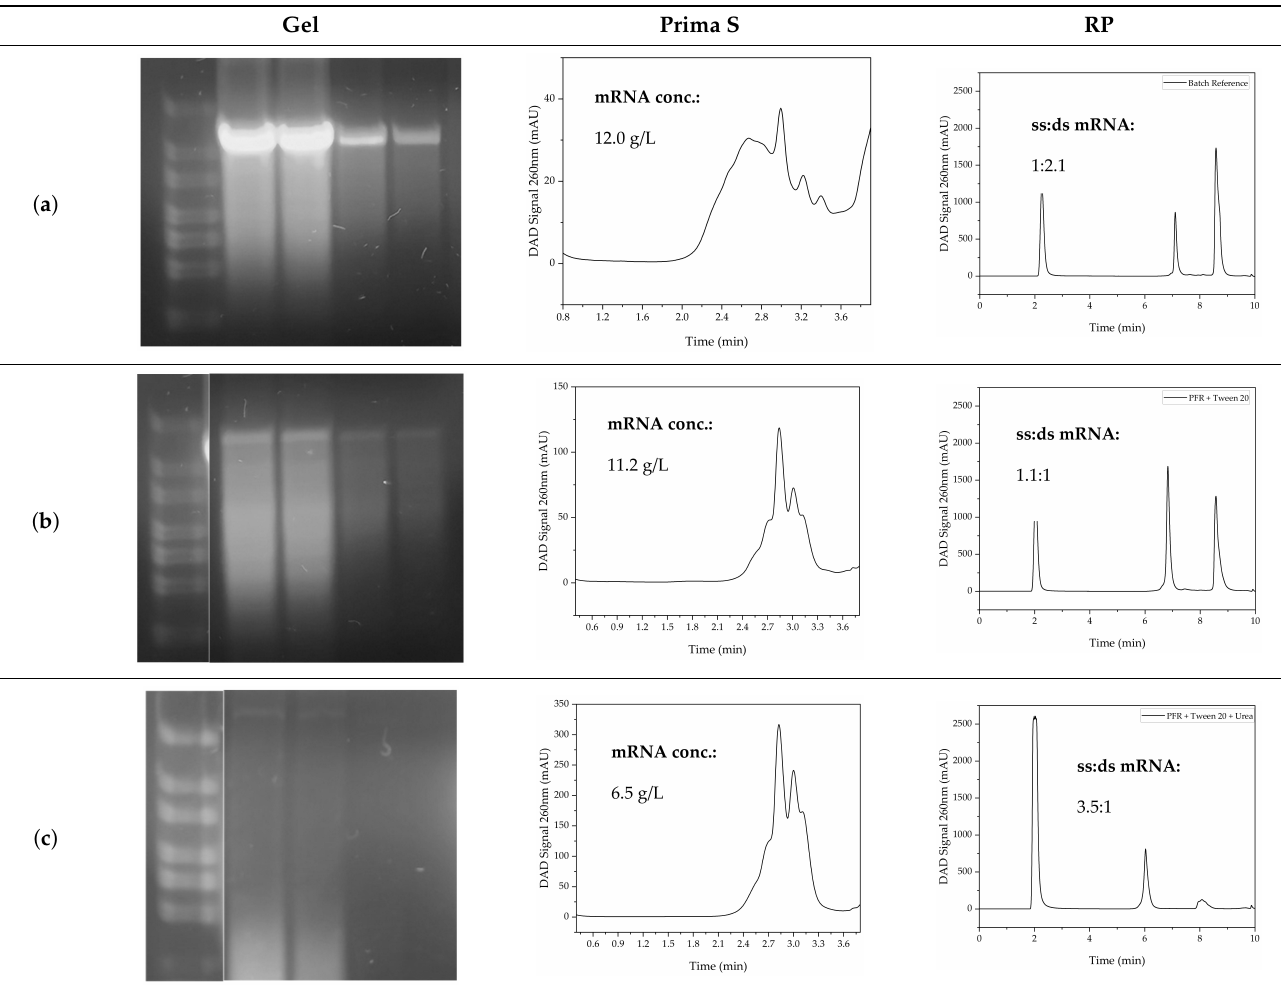
Table 8. Comparison between the IVT in batch ( a ), the IVT in PFR ( b ), and the IVT in PFR with